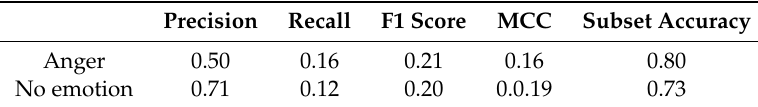
Accuracy of fine-tuned setting in Bag-of-Words representation and added features, Multi-nomial Naive Bayes classifier.